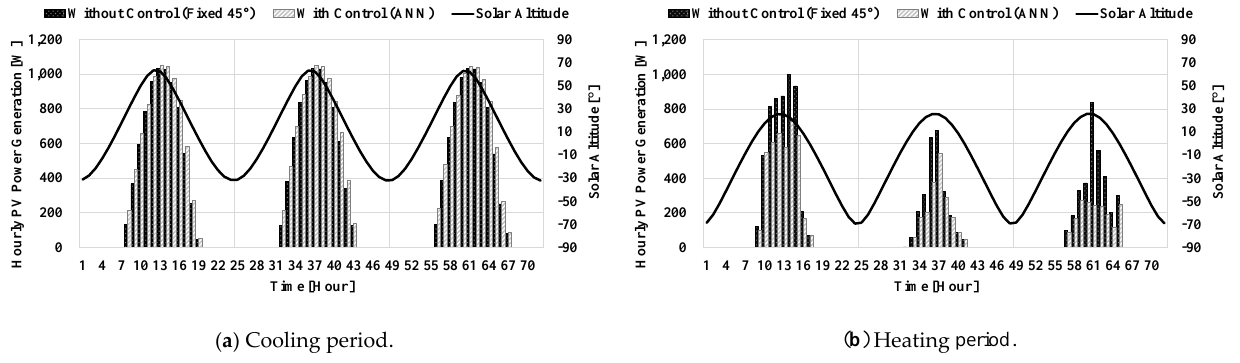
Figure 16. PV power generation with and without ANN optimal control.